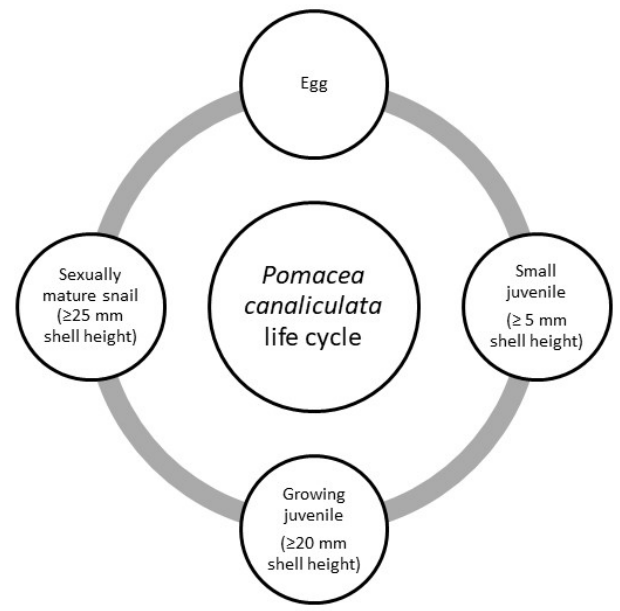
Figure 4. Life cycle of Pomacea canaliculata based on information obtained from a snail farm in the Andong region of the Republic of Korea.